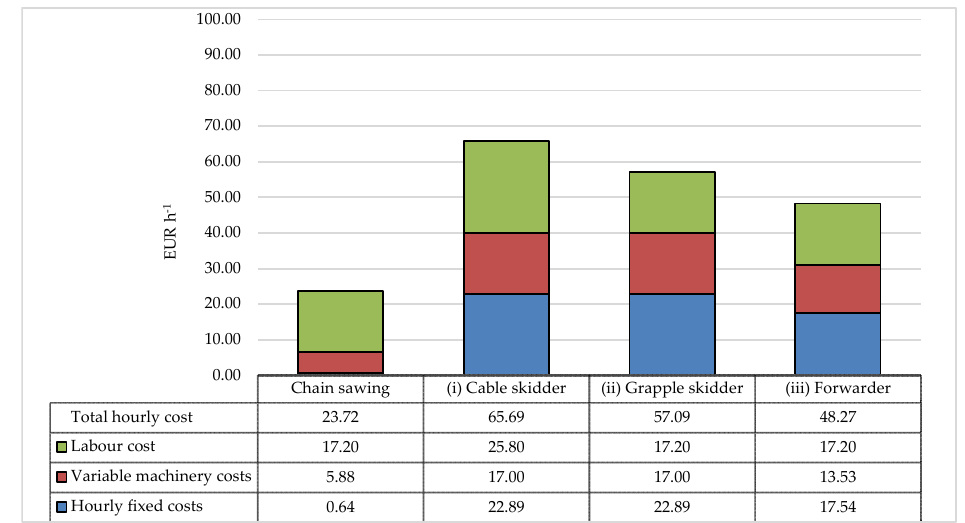
Figure 6. Hourly costs (EUR h − 1 ) of the different logging scenarios. Analysing the three different wood harvesting systems as a whole through the anal ‐ ysis of the cost of “1 m 3 of harvested wood” (Figure 7) results in even greater differences observed. Scenario (i) presents an overall cost of EUR 17,356.00 m − 3 , making it the most